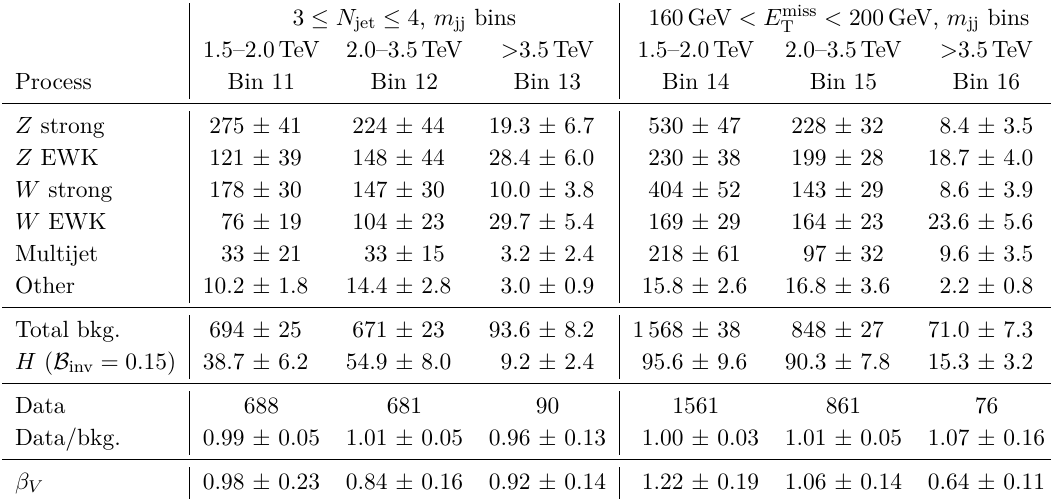
Table 7. Yields of data, signal and major backgrounds in the signal regions for each bin after the likelihood fit with µ set to zero. Minor backgrounds from t ¯ t , V V , V V V , and VBF H → W ∗ W / τ + τ − are combined and labelled ‘other’. The uncertainties in the backgrounds are derived by the fit and take into account the correlations of the background uncertainties. The predicted signal yields (VBF, ggF, and V H ) for B = 15% (the observed limit) are presented for comparison, along with their inv associated uncertainties, assuming that the experimental uncertainties are fully correlated between the ggF and VBF contributions. The β are the background normalisation V